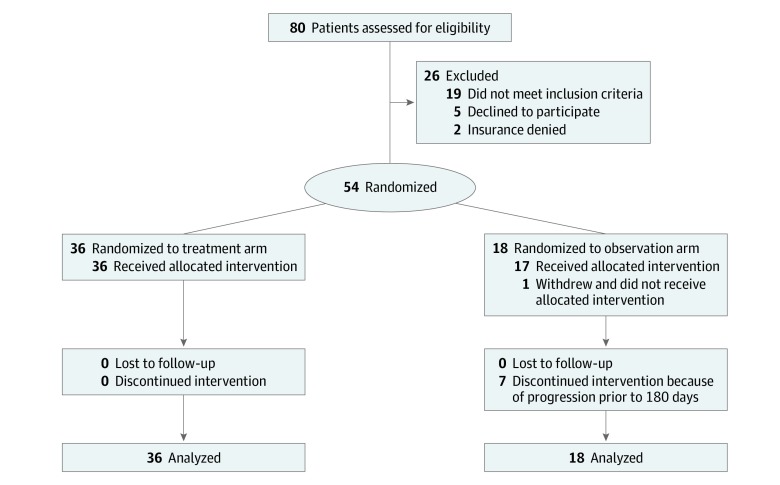
CONSORT Diagram